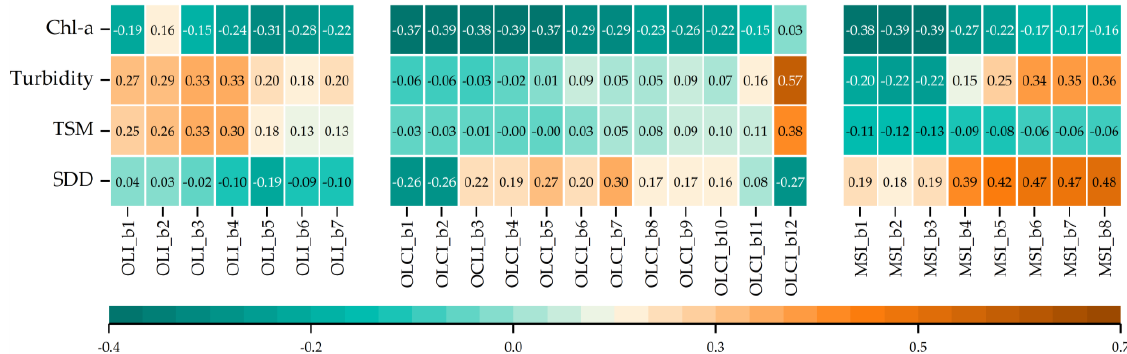
Figure 5 . Correlation matrix heatmap of reflectance values of the analyzed bands and water quality parameters. Bands of the Operational Land Imager (OLI) are shown at left, Ocean and Land Color Instrument (OLCI) are shown at the center, and Multi Spectral Instrument (MSI) are shown at the right. Table 2. Average coefficient of determination (R 2 ) of the developed models by sensor and lake together with the average number of samples (n). Operational Land Imager (OLI) (left), Ocean and Land Color Instrument (OLCI) (center), and Multi Spectral Instrument (MSI) (right).